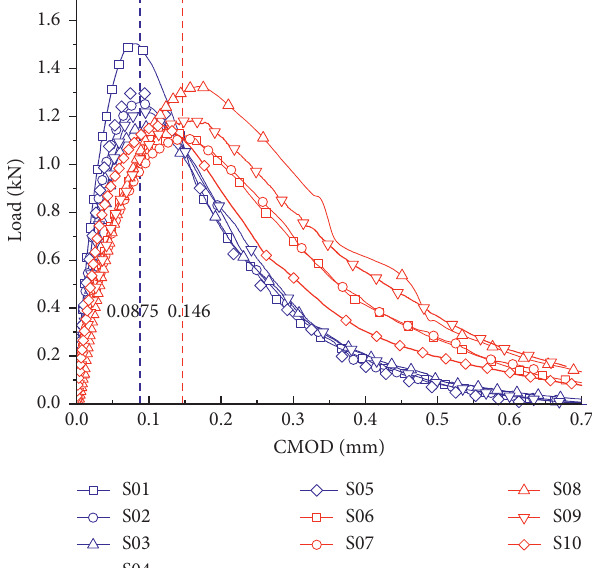
Figure 8: P-CMOD curves. The blue curves indicate the specimen at room temperature, and the red curves indicate the specimen after treatment at 600 ° C treatment. The vertical dashed line on the graph represents the average critical crack mouth opening displacement (CMODc).